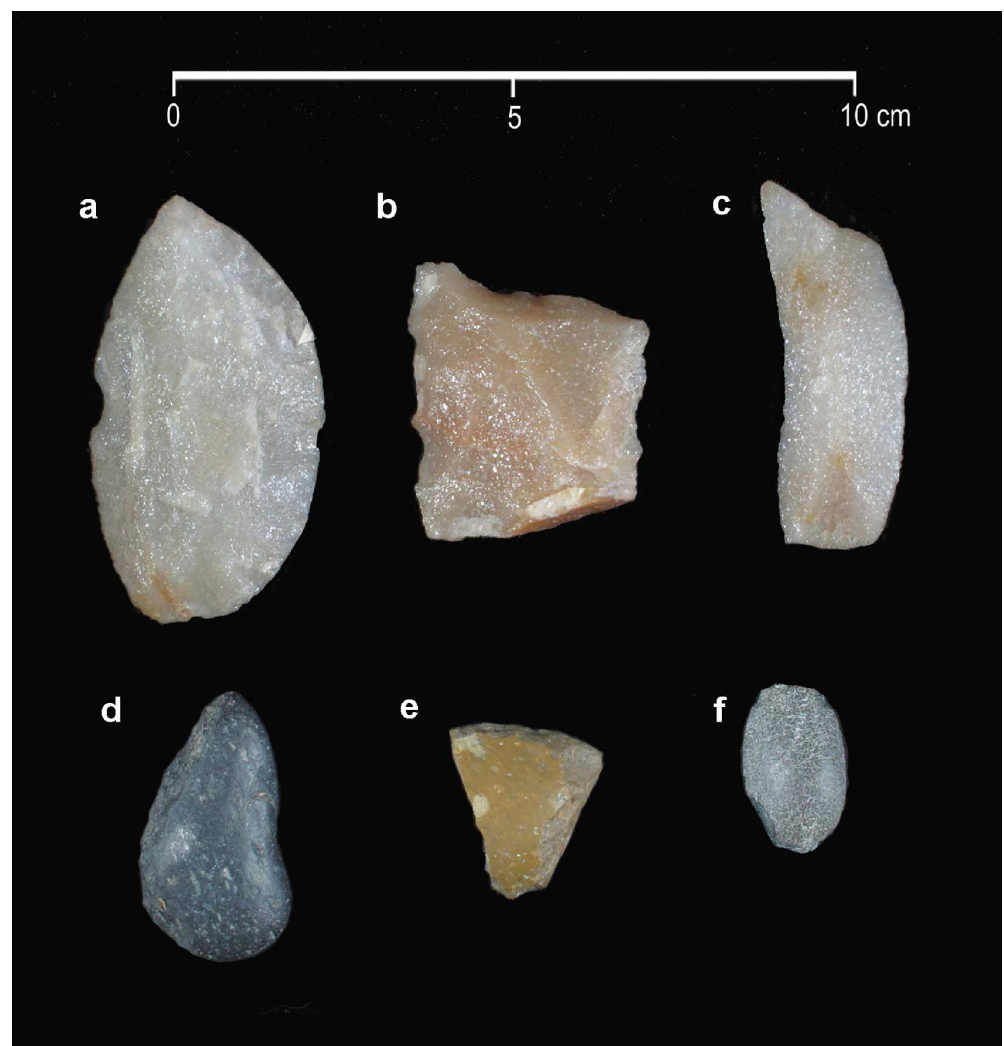
Fig 6. Sampleof the lithicartifactsfound in the levels associatedwithextinctfauna. (a) side scraper, quartzite; (b) retouchedflake, quartzite; (c) retouchedflake, quartzite; (d-e)scrapersmade on coastalrounded cobbles; (f) bipolarcobble. All materialrecovered fromthe lower partof Unit Y, Unit S, and the upperpartof Unit Z. Photograph modifiedfromLeipus and